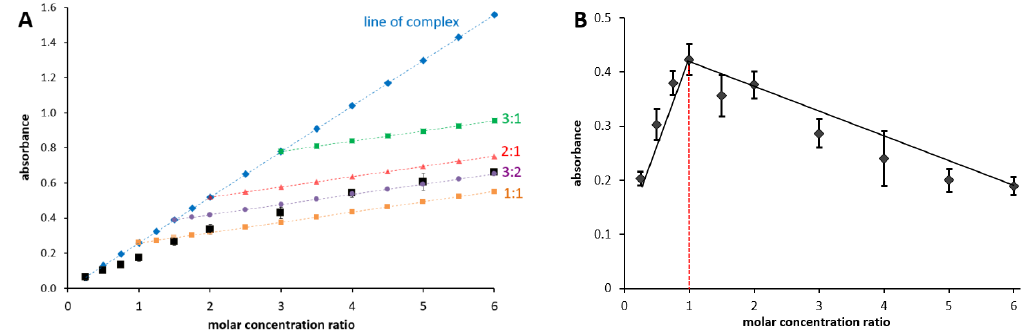
Figure 2. Assessment of the Fe 2+ -isoquercitrin complex stoichiometry at pH 6.8. Complementary approach ( A ): the final molar concentration of ferrous ions was 15 µ M and the final molar concentration of isoquercitrin was 4–90 µ M. The blue line corresponds to the absorbance of the formed